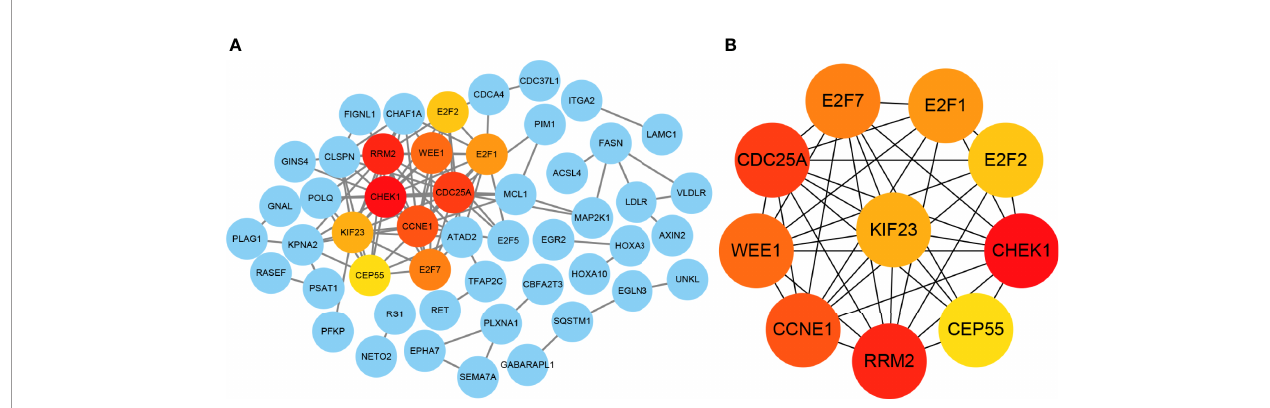
FIGURE 7 | Identi fi cation of hub genes from the PPI network with CytoHubba. (A) Visualization of PPI network. The network was established by STRING and visualized by Cytoscape. Each circle represents each potential downstream mRNA, and the lines represent the interactions among these mRNAs. Hub genes with the most interactions are highlighted in the current PPI network. (B) Correlation between the hub genes. PPI, Protein-protein interaction.